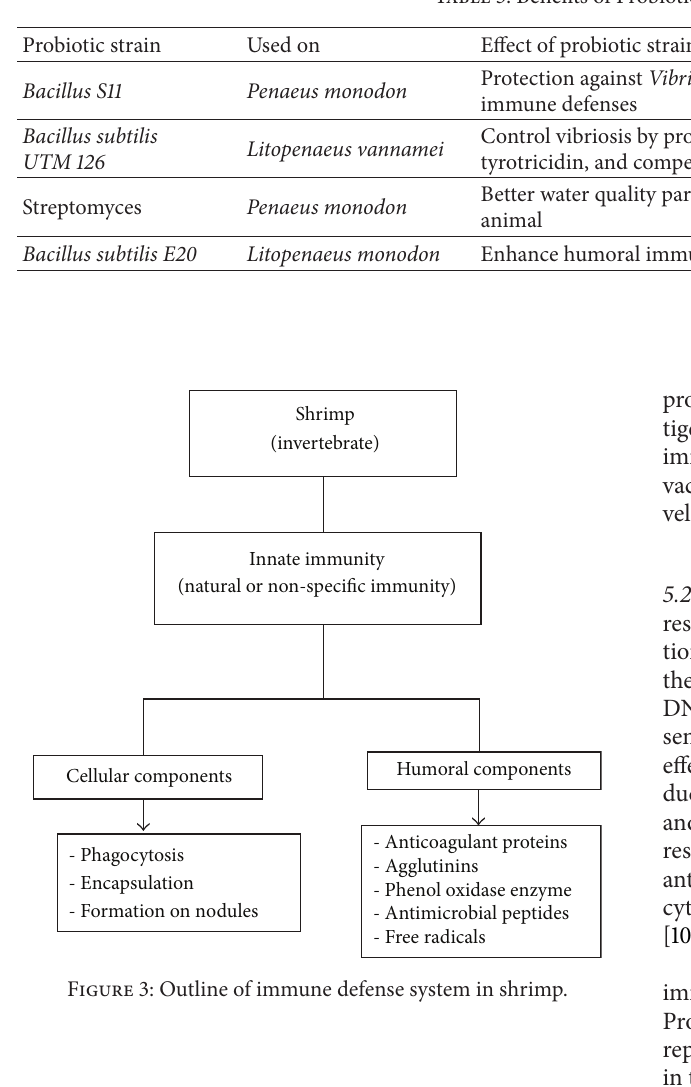
Table 3: Benefits of Probiotics in aquaculture.